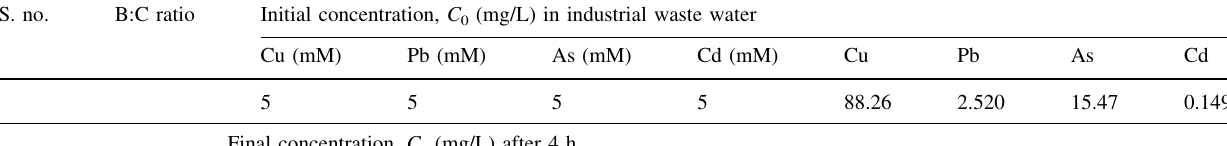
Table 2 Initial and remaining heavy metals concentration in synthetic solutions and industrial wastewater samples S. no.